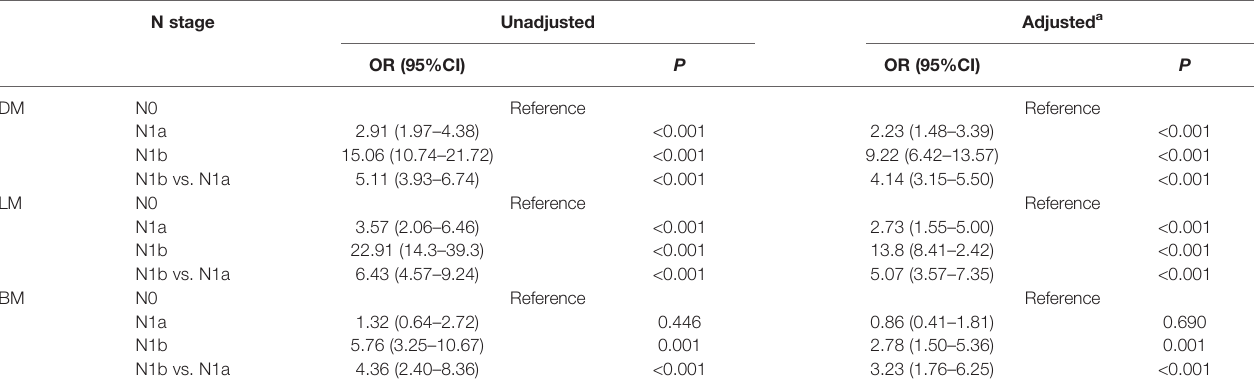
TABLE 2 | The impact of N classi fi cation on distant